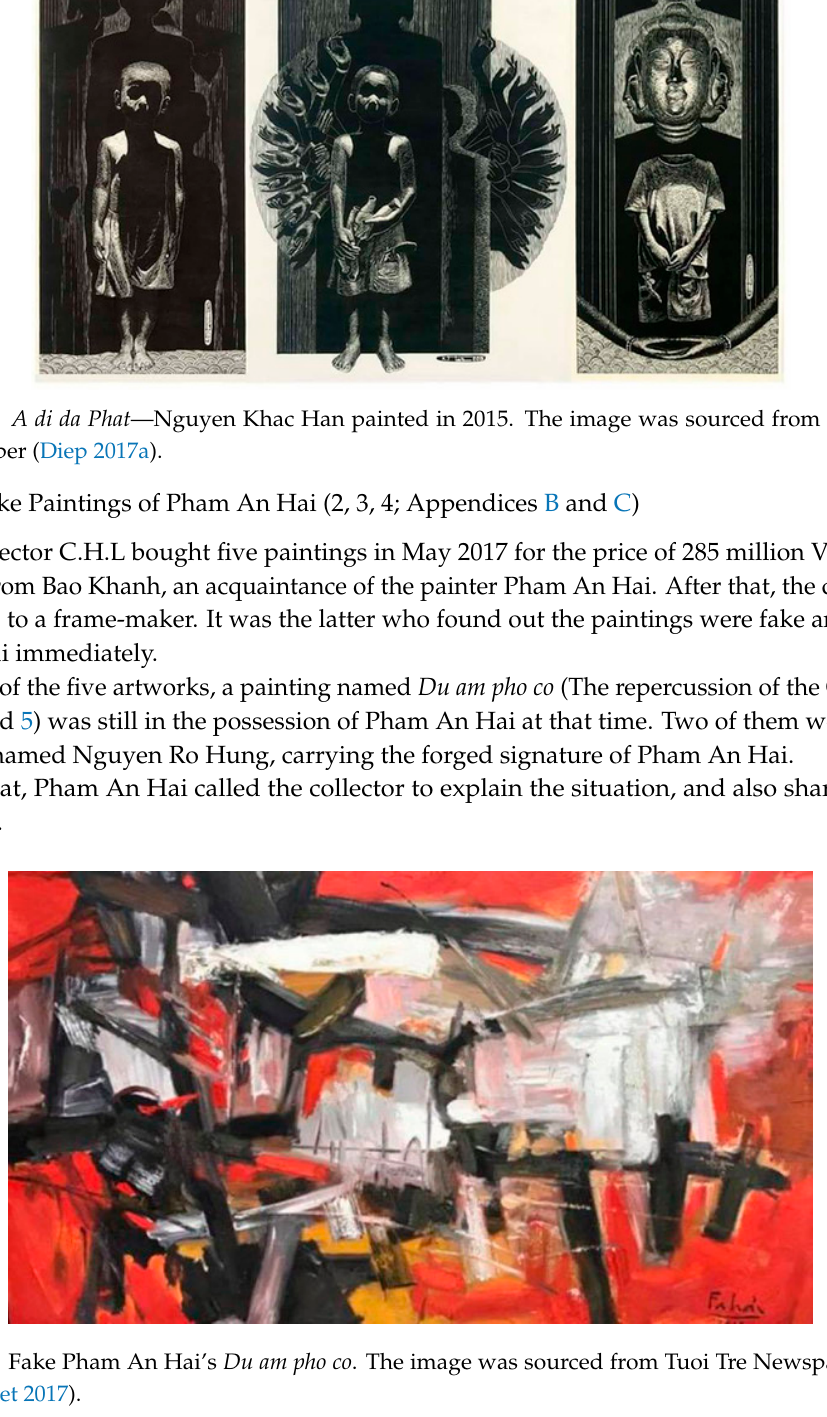
Figure 2. An Lac —Nguyen Truong An painted in 2017. The image was sourced from Tuoi Tre Newspaper (Diep 2017a).